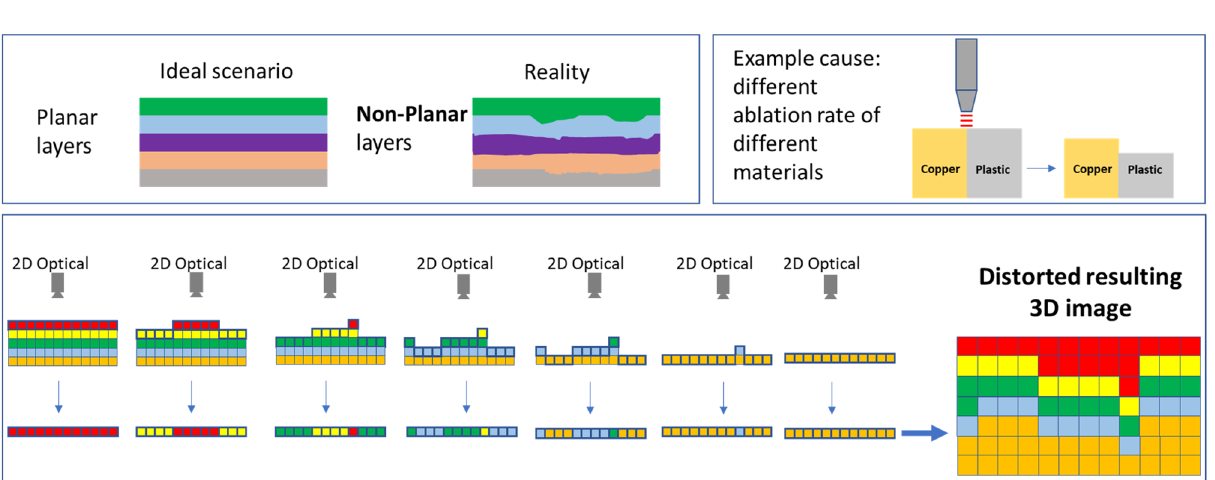
Figure 1. The challenge of stacking 2D images for obtaining a 3D image: due to nonplanarity of the 2D layers, the resulting 3D image will be